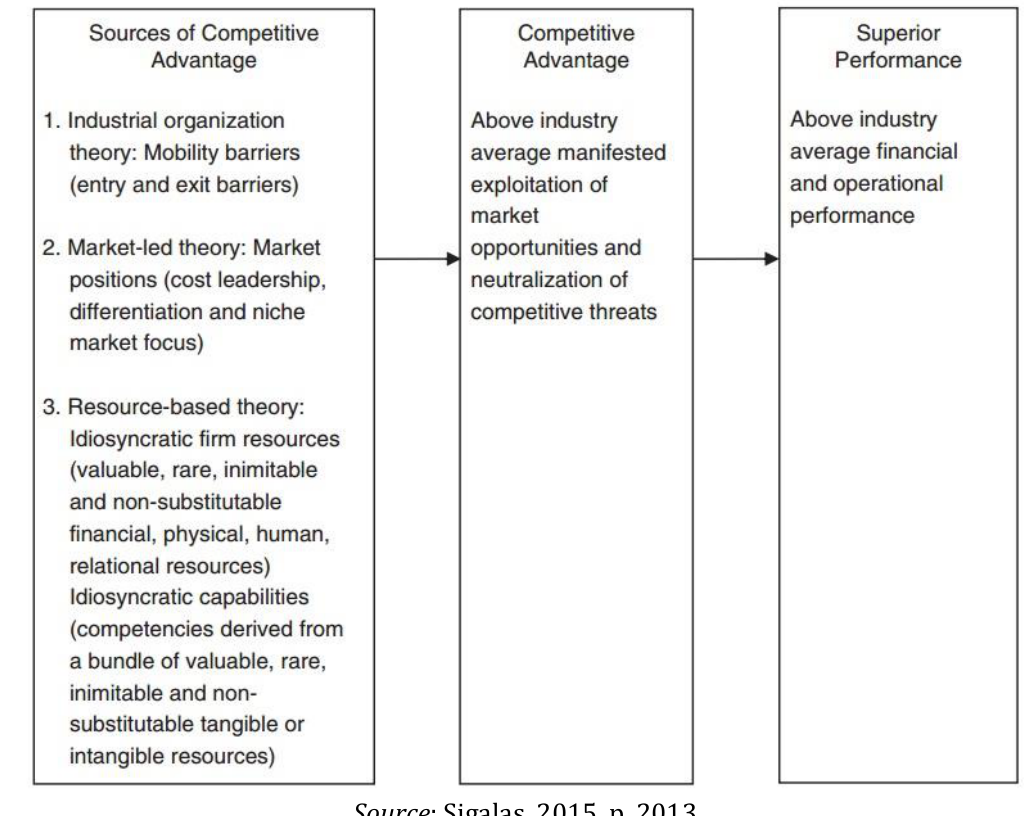
Figure 7: Framework for “Sources of Competitive Advantage”